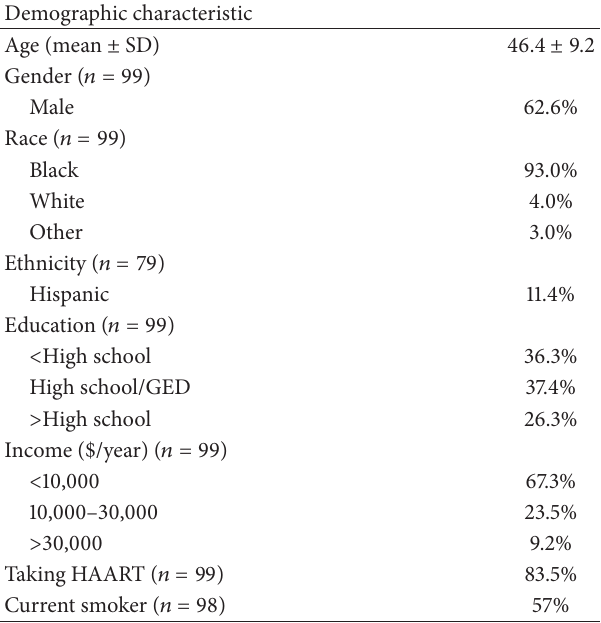
Table 1: Demographic characteristics of study sample.